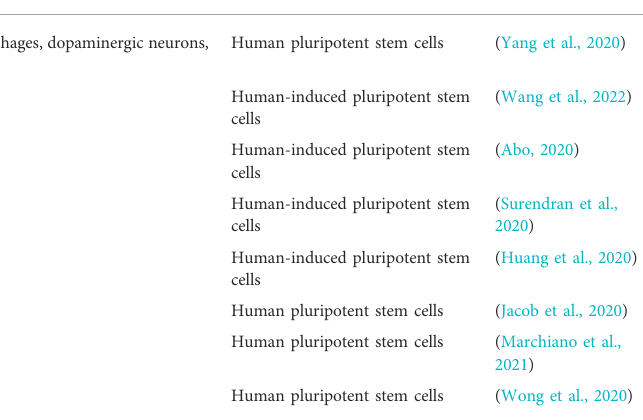
TABLE 1 List of cell models of COVID-19 modeling using pluripotent stem cells. Cell